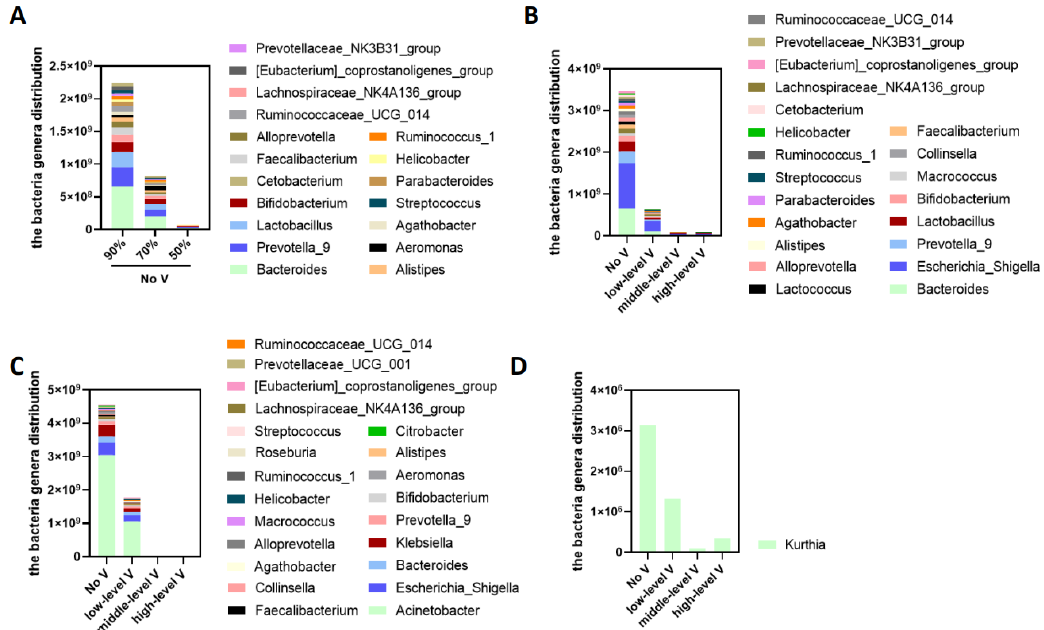
Figure 8. The effect of humidity and ventilation on the bacterial genera distribution at 34 ◦ C. ( A ) The effect of different humidity levels (90%, 70%, 50%) on bacterial genera without ventilation; ( B ) the effect of ventilation on bacterial genera under 90% humidity; ( C ) the effect of ventilation on bacterial genera under 70% humidity; ( D ) the effect of ventilation on bacterial genera under 50% humidity.